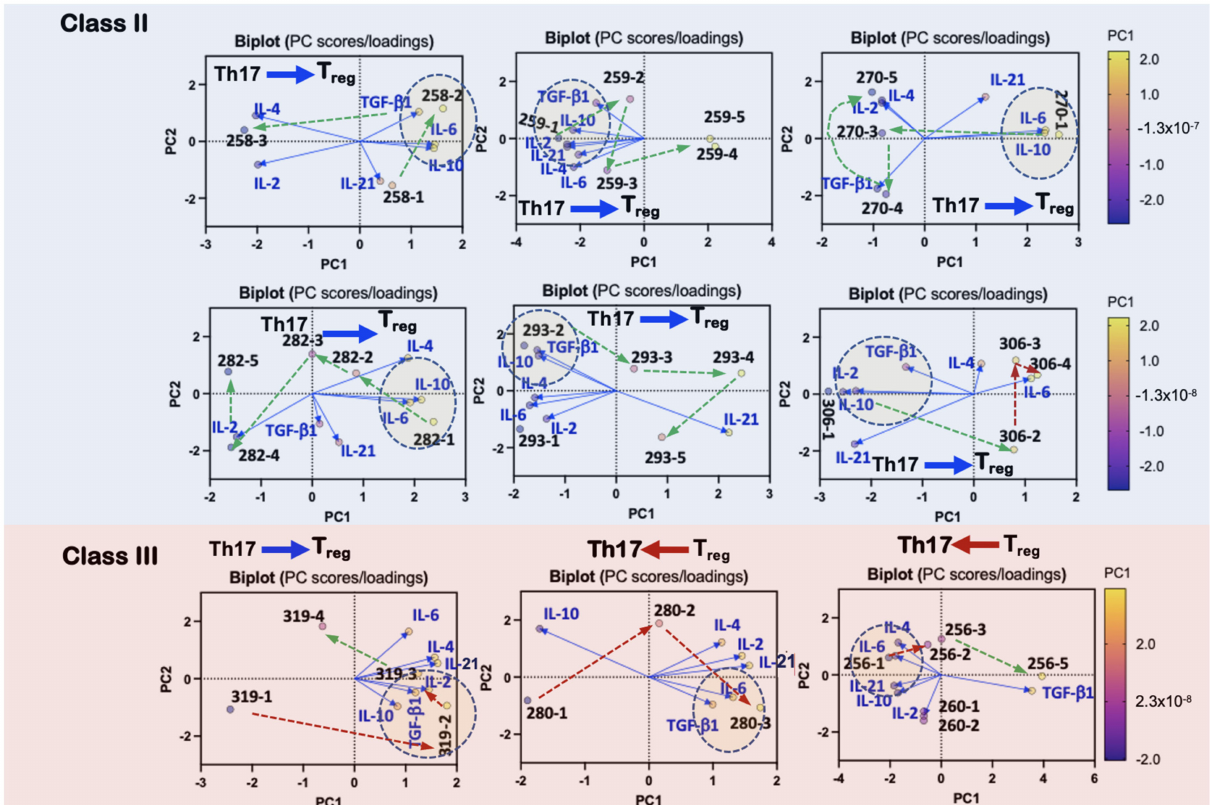
Figure 7. Immune correlates of Treg-mediated outcomes. Principal Component Analysis (PCA) of Class II and III patient variables IL-2, IL-4, IL-6, IL-10, and TGF- β 1 associated with Treg differentiation. The Th17/Treg blue or red arrows indicate the favored choice of differentiation. Patient PC scores are shown as case ID and days post admission (e.g., 258-1). Conditions that favor Treg differentiation are indicated by the dotted oval highlighting the correlation of Treg promoting cytokines, e.g., correlated clusters of IL-10 (effector Treg cytokine), IL-6 (low expression), and TGF- β 1. For Class III, 280 demonstrates unchecked growth of a proinflammatory state based on the spatial positioning of 280-1, 280-2, and 280-3 relative to the cytokines. The 180 ◦ separation of the low-concentration IL-10 and the closely correlated TGF- β 1/IL-6 signaling axis is consistent with prevailing conditions for an imbalance between Th17/Treg states in favor of Th17. 260-1, 260-2: insufficient data for only two